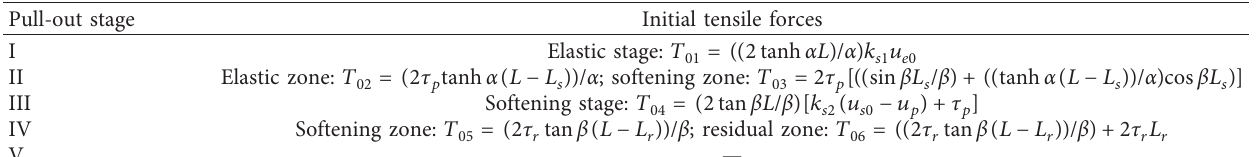
Table 6: Initial tensile forces at different stages of the softening pull-out model.